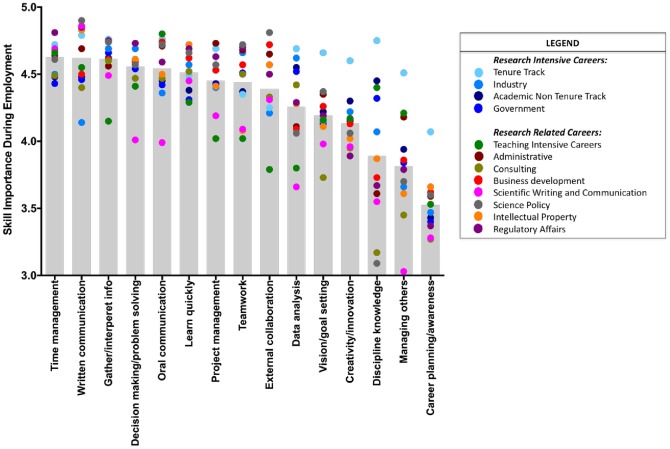
Transferrable skill importance for employment by career track.Currently employed PhDs rated the importance of each skill for their current role (“Other” responses not included on the plot above). The overall mean importance rating for each transferrable skill during employment is represented by a corresponding grey bar, ordered from left (highest) to right (lowest). Each career track mean is represented by a color-coded dot overlaid on the grey bar corresponding to each transferrable skill.